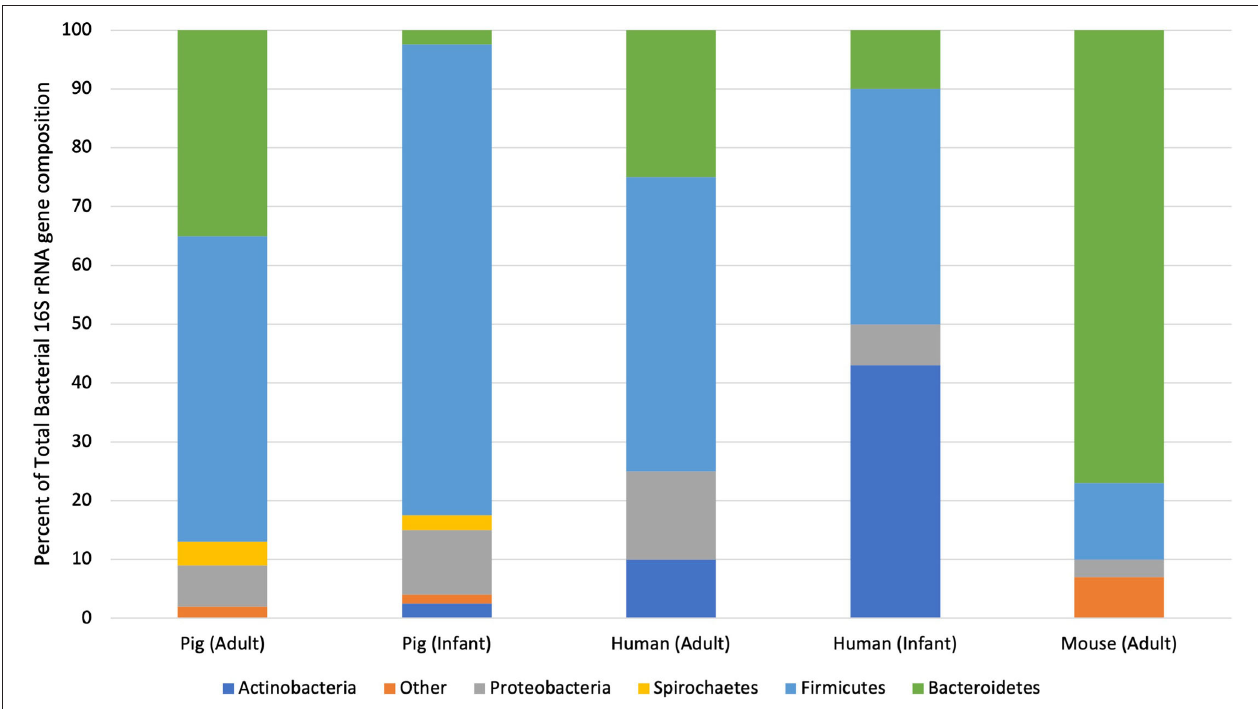
FIGURE 2 | Taxonomic distribution of bacterial phyla from pigs, humans and mice at different life stages. This graph illustrates the percent of sequences assigned to each bacterial phylum isolated through 16S rRNA sequencing of pooled fecal samples isolated from healthy individuals of each species ( 33, 36,